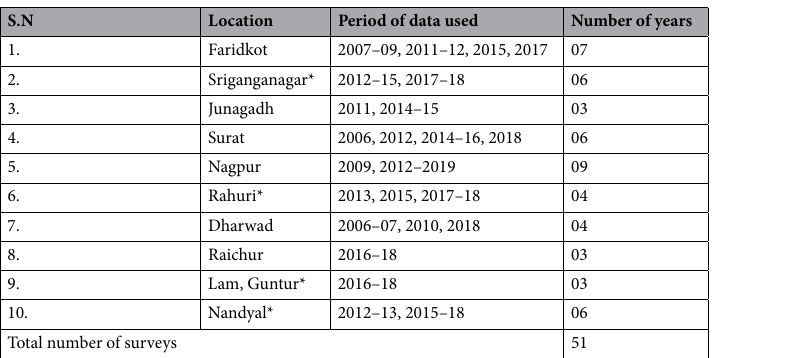
Table 7. Locations wise details of weather data and pink bollworm moth trap catches data used for analysis in present study. The locations with availability of minimum three years of both data sets were only selected. *Monthly mean values of minimum and maximum temperatures were